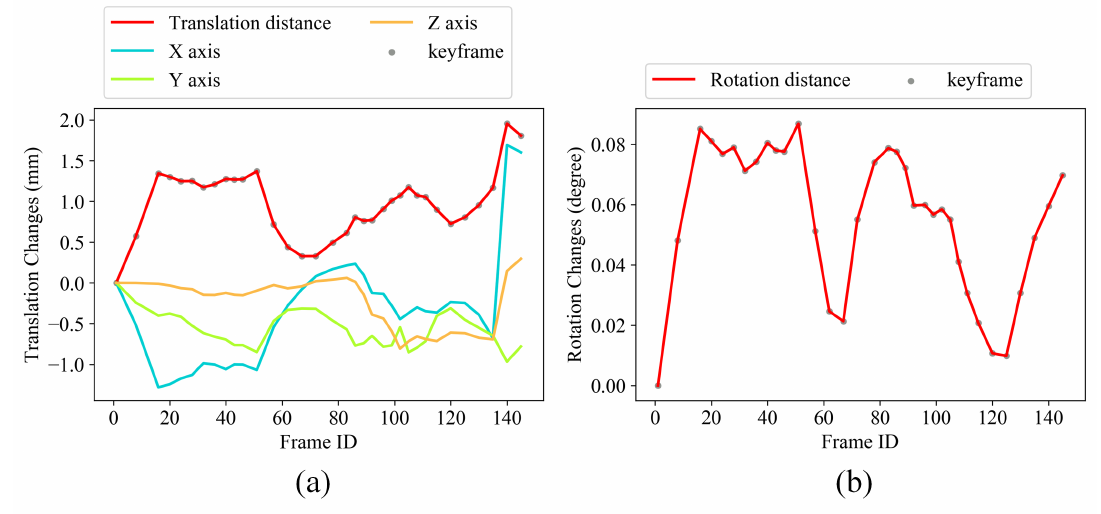
Figure 11. ( a ) Relative translation and ( b ) Rotation changes of each keyframe